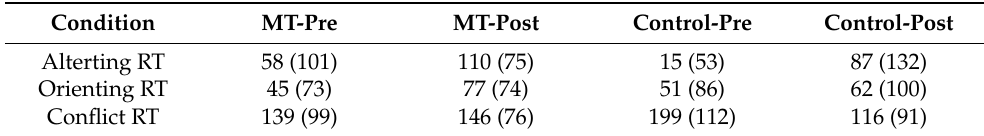
Table 2. ANT Attention RTs (ms): Mean (standard